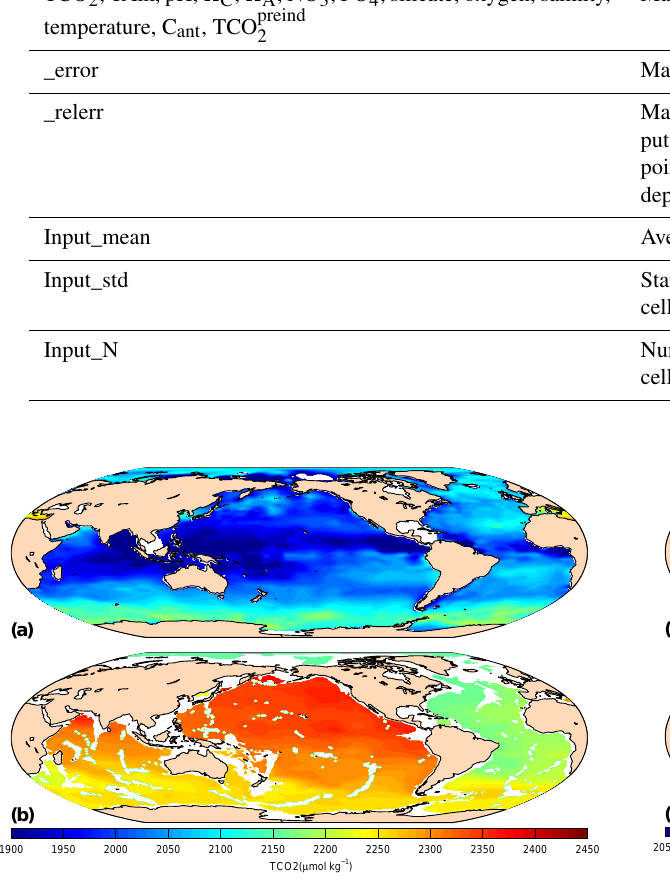
Figure 3. Mapped climatology of TCO 2 at 10m (a) and 3000m (b) . Figure 4. Mapped climatology of TAlk at 10m (a) and 3000m (b) .